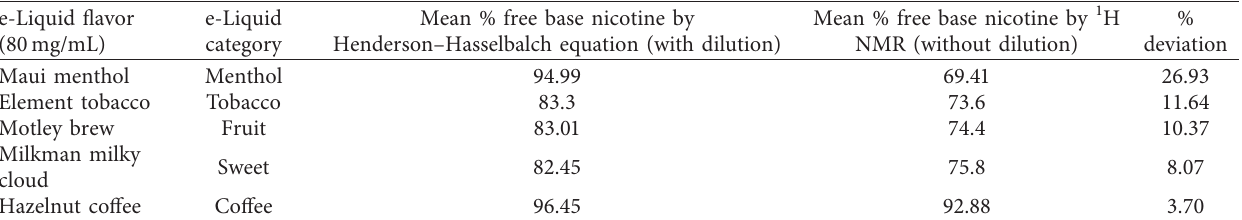
Table 6: Comparison between free base nicotine in e-liquids by dilution approach (HH) and by without-dilution approach ( 1 H NMR) (e- liquids without